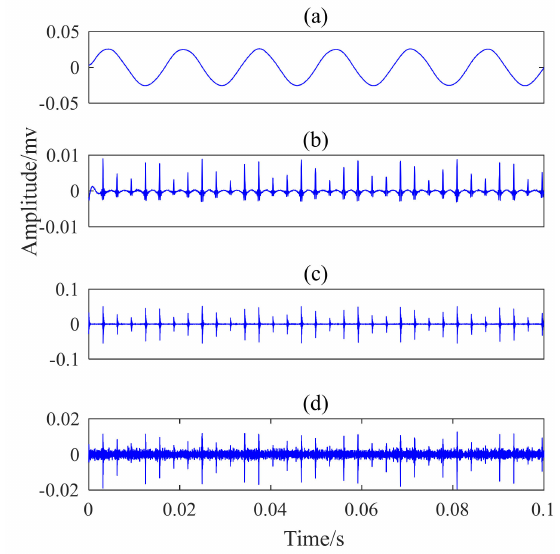
Figure 7. The IMFs of simulation signal obtained by the Improved EWT method: ( a ) IMF1; ( b ) IMF2; ( c ) IMF3; ( d )